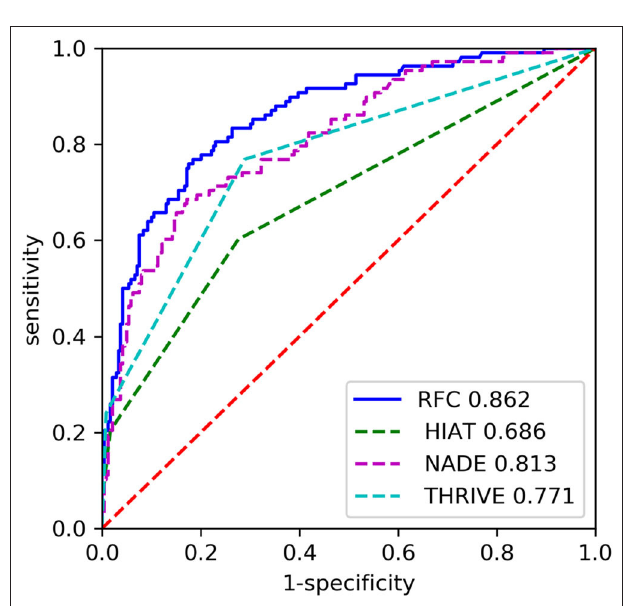
FIGURE 3 | The receiver operating characteristic (ROC) curves of the random forest classifier (RFC) and previous models on the testing set. HIAT, Houston Intra-Arterial Therapy score; THRIVE, Totaled Health Risks in Vascular Events score; NADE, NIHSS score on admission, age, previous diabetes mellitus and